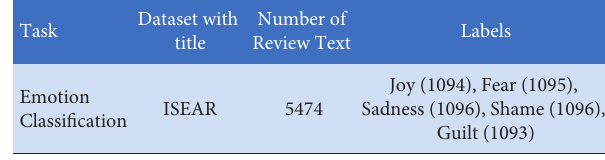
Figure 1: The dataset’s description.